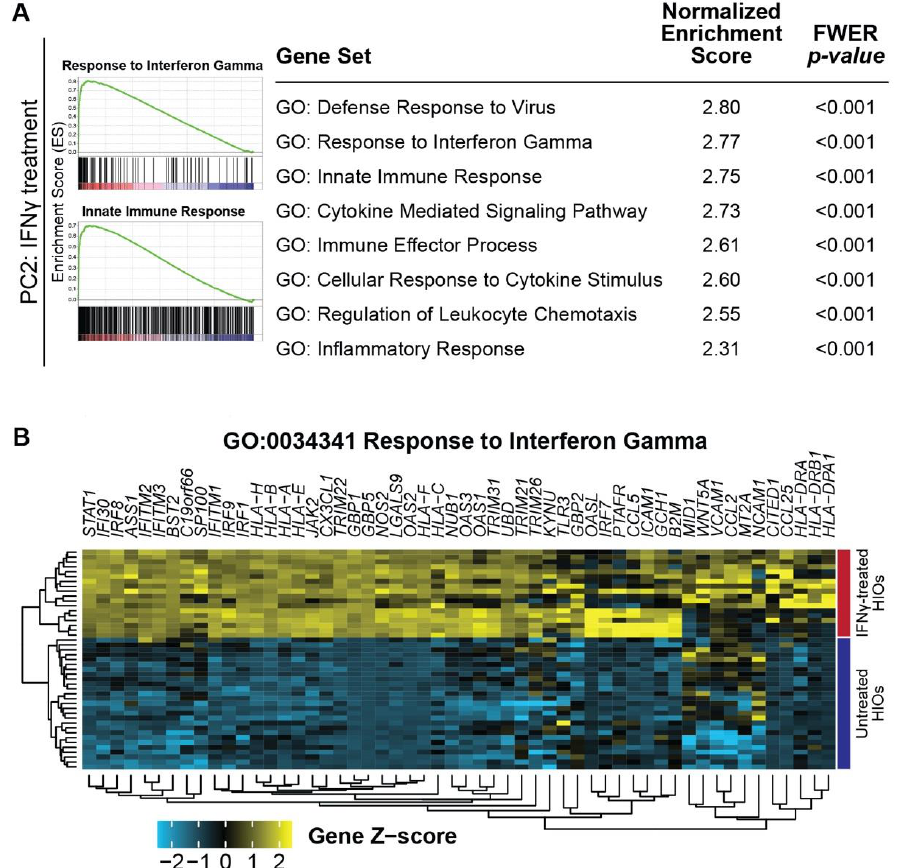
Figure 4. GSEA reveals enrichment of immune-related pathways in IFN-γ-treated HIOs. ( A ) En- richment plots and enriched GO term gene sets in the ranked PC2 gene loadings using gene set enrichment analysis (GSEA). ( B ) Heatmap of the leading edge genes driving enrichment of ‘GO: Response to Interferon Gamma’ in IFN-γ-treated HIOs.